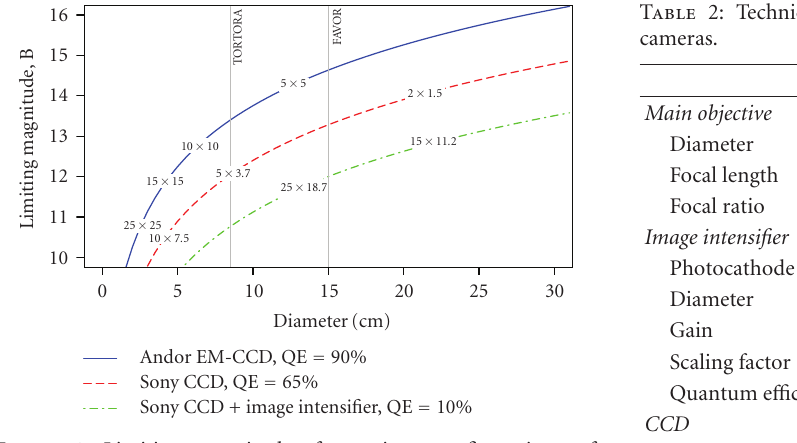
Figure 1: Limiting magnitudes for various configurations of objective diameter and CCD used. The Sony ICX285AL 1388 × 1036 CCD with 6.5 μ m pixels and 6e − read-out noise, without and with the image intensifier used to e ff ectively shorten the focal length 7.7 times, is compared to the Andor iXon EM + 888 1024 × 1024 EM-CCD with 13 μ m pixel and 0 . 5e − read-out noise. The objectives are assumed to have D/F = 1/1.2. Vertical gray lines mark the objective sizes of FAVOR and TORTORA cameras. Numbers inside the lines represent the corresponding sizes of the field of view. The limiting magnitudes are in B band for 0.13 s exposure. For TORTORA camera, the e ff ective diameter is shown, which √ 2 times smaller than the input window size due to multi- is mirror objective design which reflects back approximately 50% of incoming light. The variant with a low-noise EM-CCD is obviously the best in sensitivity, while the one with the image intensifier is far superior in a size of field of view.